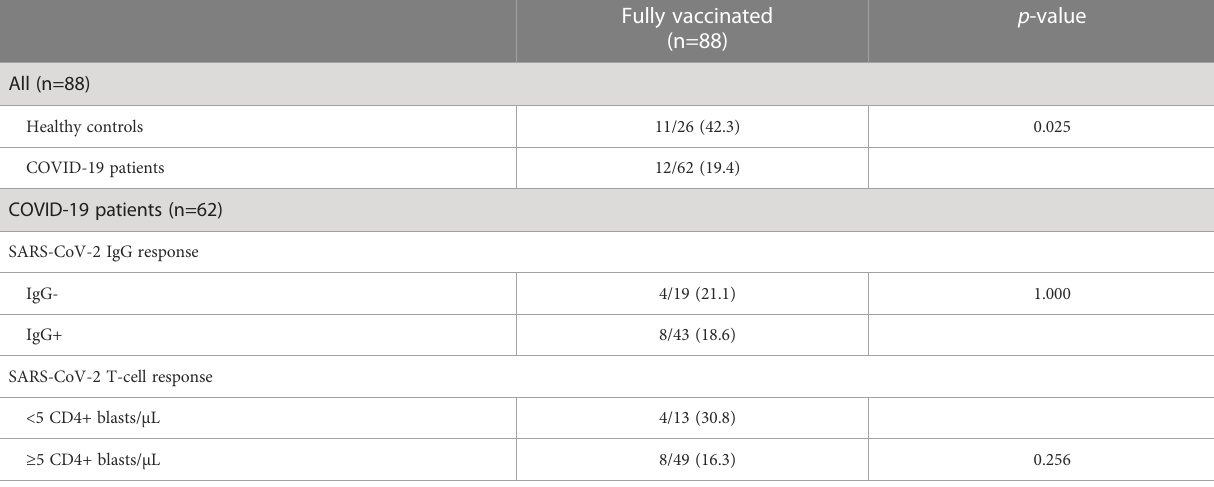
Fully vaccinated